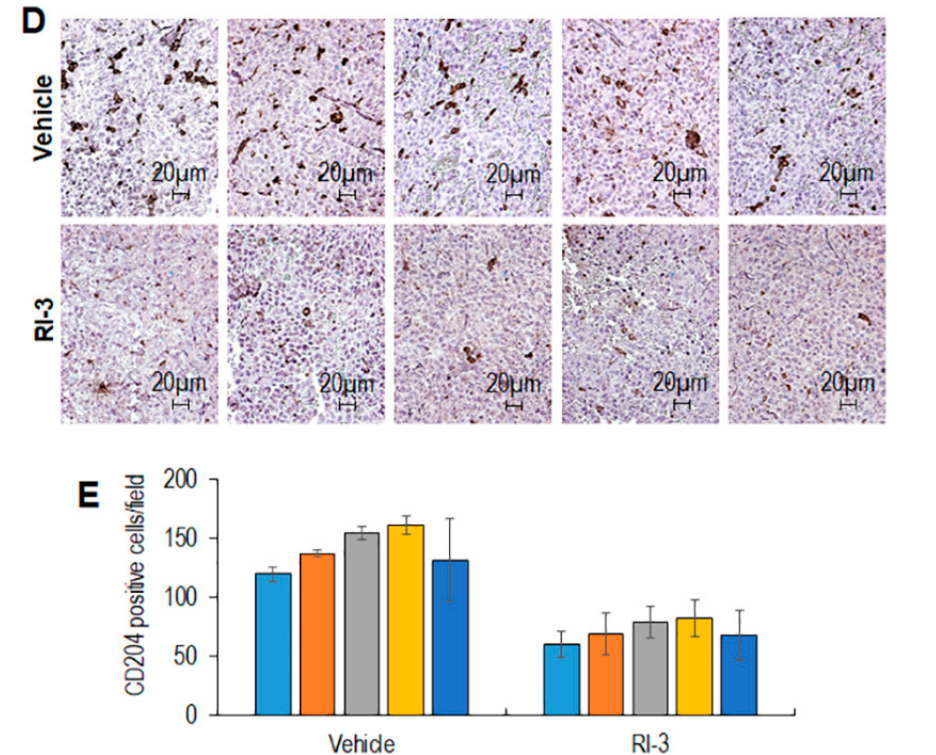
Figure 7. Effect of the peptide RI-3 on monocyte recruitment and TAM infiltration into CHS tissues. Endothelial cells (HUVEC) were seeded in E-plates and allowed to adhere for ~25 h, until they formed a confluent monolayer. Then, monolayers were overlaid with THP-1 cells ( A ), human ( B ) or murine ( C ) monocytes in growth medium, in the absence or presence of 10 nM RI-3. Endothelial invasion by monocytes was monitored in real-time for 10 h as changes in Cell Index. Values were normalized immediately after monocyte addition. Data represent mean ± SD from a quadruplicate experiment. ( D , E ). Ten 6–8 week-old Foxn1 nu / nu mice received an injection of CHS cells into the right flank as a single-cell suspension. Animals were randomized into two 5-mice groups with the treatment group receiving 6 mg / kg RI-3 by intra-peritoneal injection every 24 h, and the control group receiving an equivalent injected volume of vehicle. After 12 days, the animals were sacrificed, the excised tumors fixed in buffered formalin, processed for paraffin sectioning and then immunostained with anti-mouse-CD204. ( D ). Representative images of CD204 immunostaining are shown. ( E ). CD204 + cells revealed by IHC were counted in 5 randomly chosen fields per section, at 200 × magnification and averages plotted. Statistical significance with * p < 0.0001.